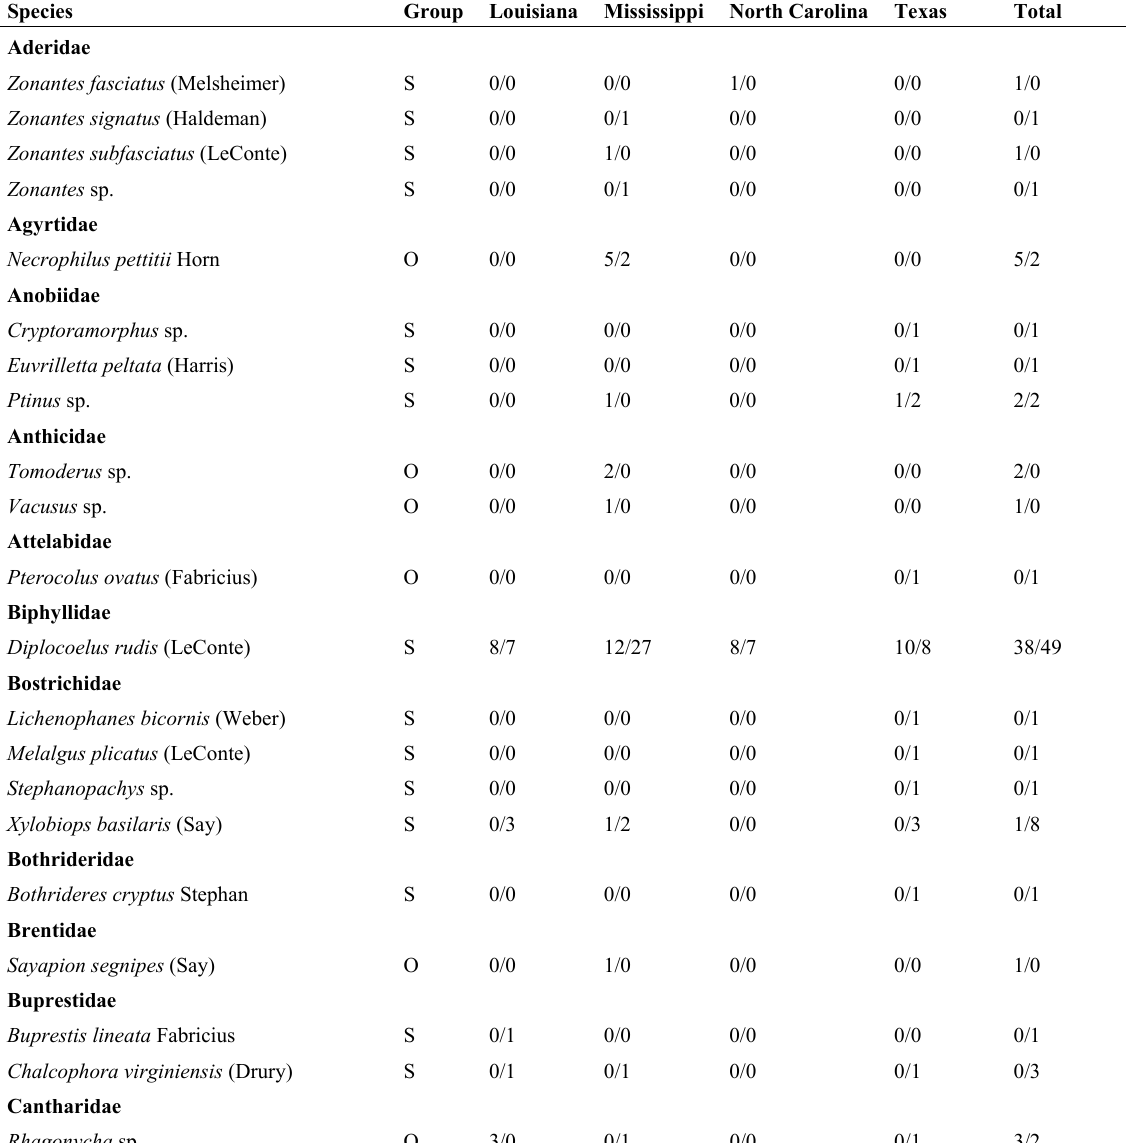
Table A1. Total beetle abundance by species, state, and treatment